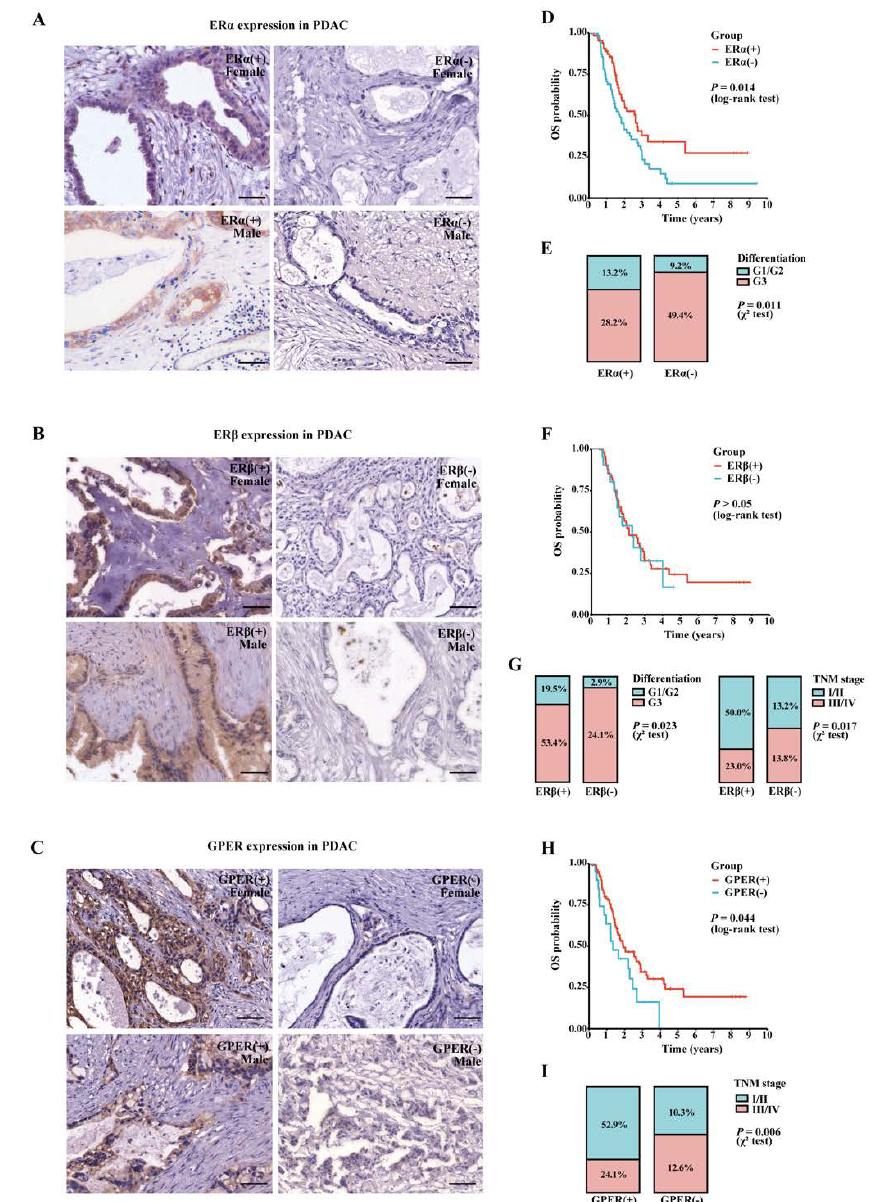
Figure 3. Expression patterns of ERα/β and GPER in PAAD tumor tissues. ( A ) Representative im- ages of ERα staining in PAAD samples from male and female patients; scale bar: 50 µm. ( B ) Repre- sentative images of ERβ staining in PAAD samples from male and female patients; scale bar: 50 μm. ( C ) Representative images of GPER staining in PAAD samples from male and female patients; scale bar: 50 μm. ( D ) The overall survival curves of ERα (+) and ERα (− ) patients. ( E ) Association between ERα expression and tumor grade in 174 patients. ( F ) The overall survival curves of ERβ (+) and ERβ (− ) patients. ( G ) Association between ERβ expression and tumor grade, TNM stage in 174 patients. ( H ) The overall survival curves of GPER (+) and GPER ( − ) patients. ( I ) Association between GPER expression and tumor grade in 174 patients.